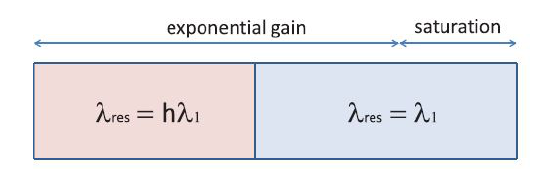
Figure 6. Conceptual scheme of a harmonic lasing self-seeded (HLSS) FEL.